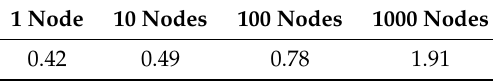
Table 2. Time (in ms) to get a node fully available (initial key agreement) in the secured wireless sensor network (WSN), using keys of 1024 bits.